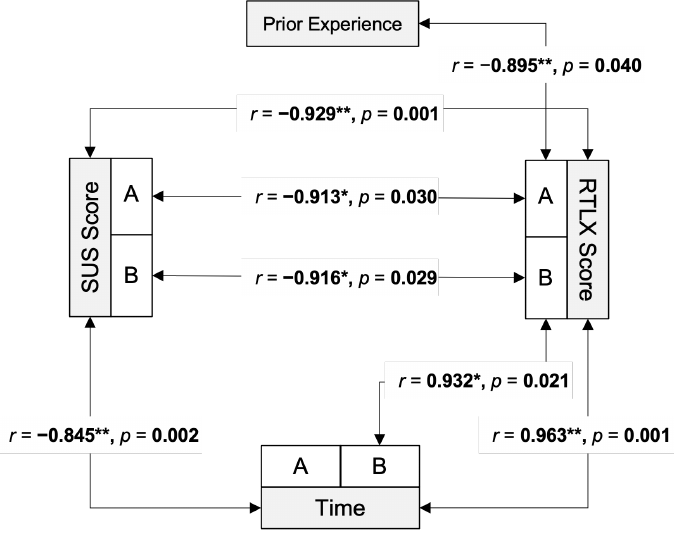
Figure 5. Significant correlations between